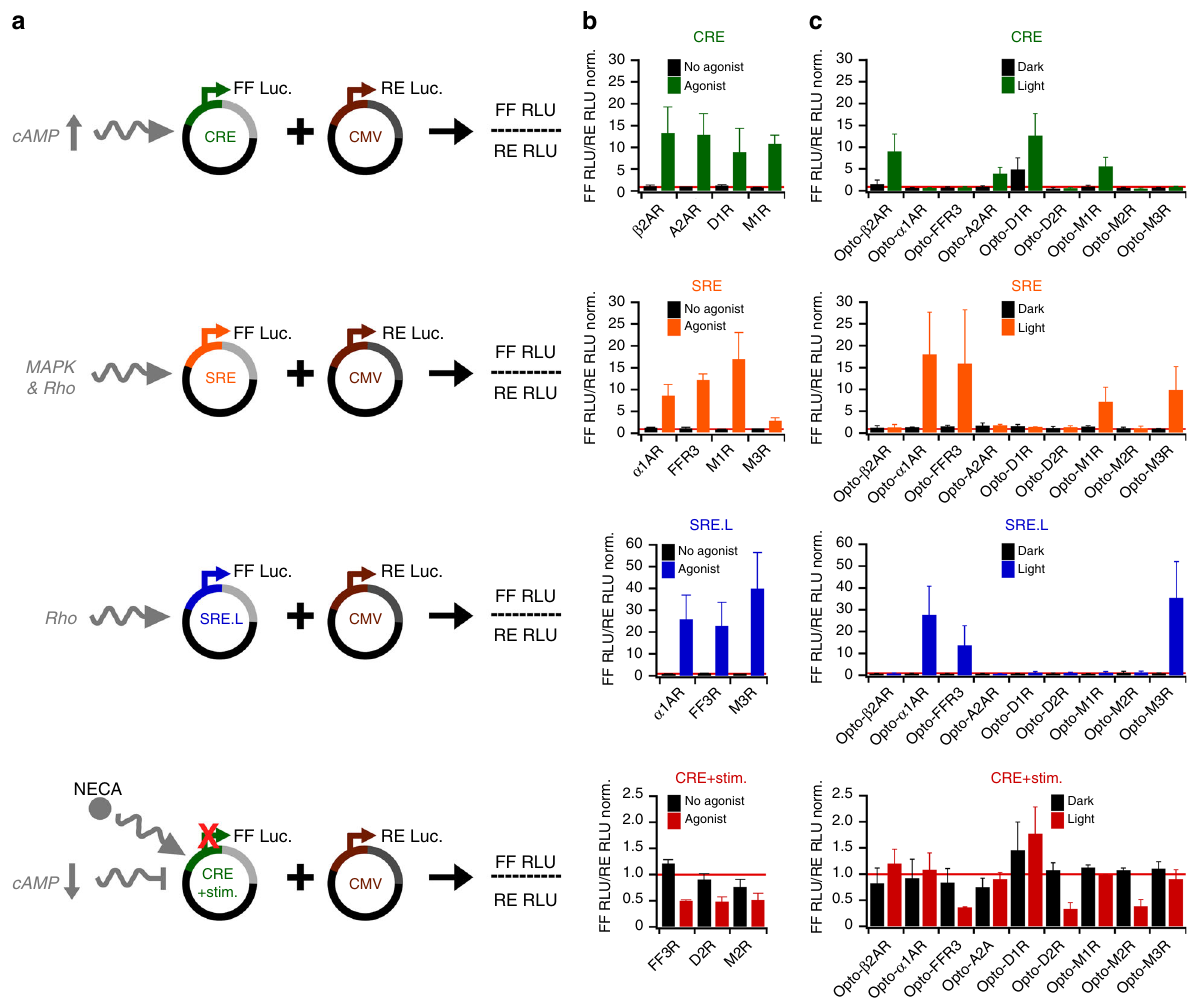
Fig. 2 Reporter assay and light-activated reference GPCRs. a Reporter vectors express fi re fl y luciferase (FF) under the control of signaling-speci fi c enhancers and were co-transfected with Renilla luciferase (RE) to normalize for cell numbers/transfection ef fi ciencies. Relative light units (RLU) were detected for both luciferases separately. b Reporter activation by reference GPCRs stimulated by agonists (Supplementary Table 2; here, only receptors that stimulated reporters are shown). c Reporter activation by the light-activated variants of reference GPCRs. In b and c , mean values ±s.e.m. ( n = 6 – 8, 3 – 4 independent experiments) are shown. In tests for cAMP reduction, cAMP production was stimulated chemically before light treatment, as described in